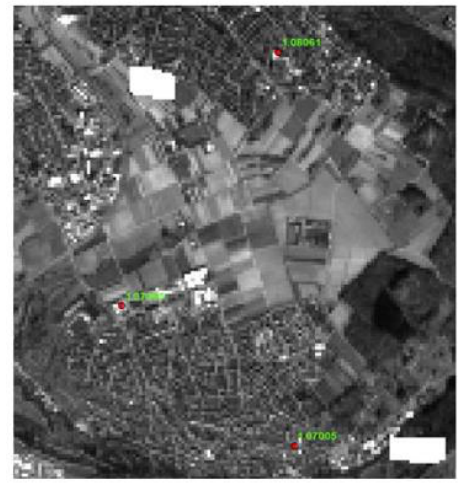
Figure 5. Location of artefacts found between iCOR and Sen2Cor reflectance values.